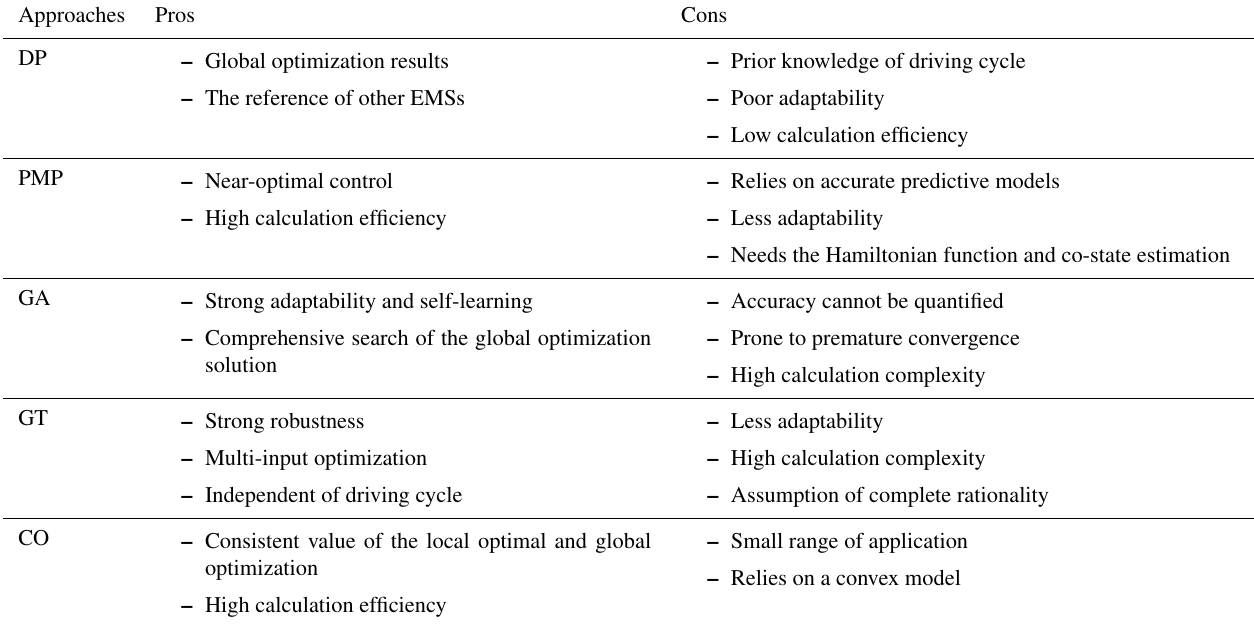
Table 4. The comparison of different methods applied to the global optimization EMS.